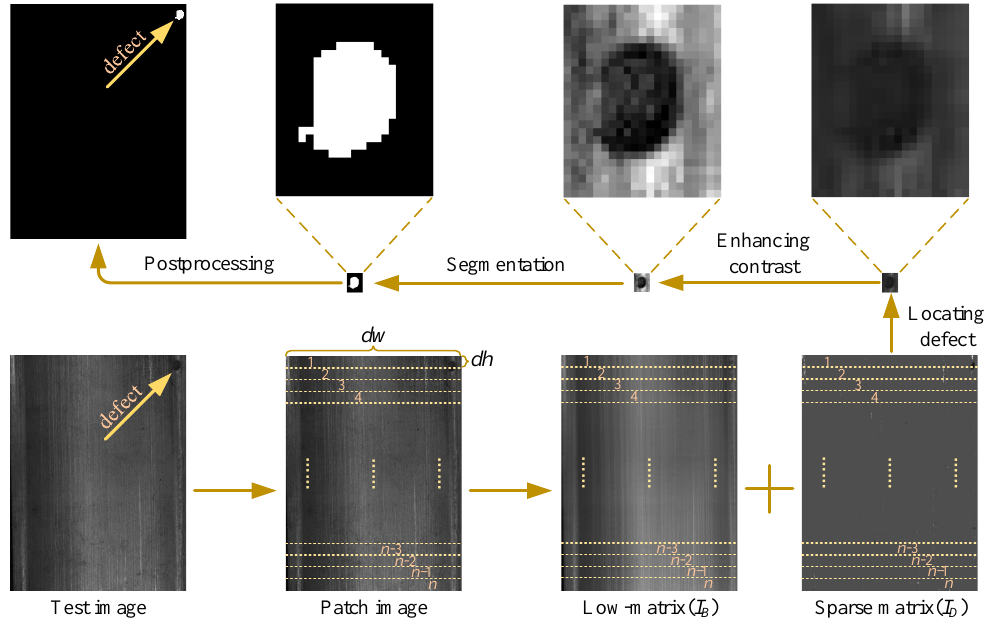
Figure 2. Overall flowchart of this